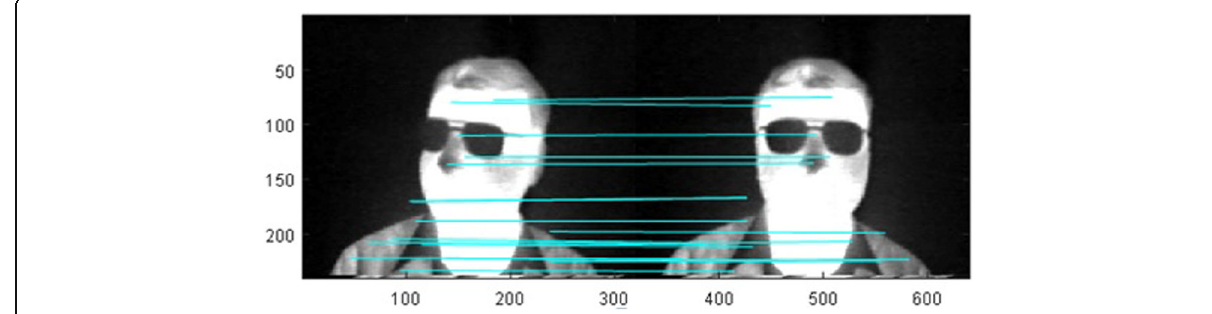
Fig. 11 Matching results when head rotation angle